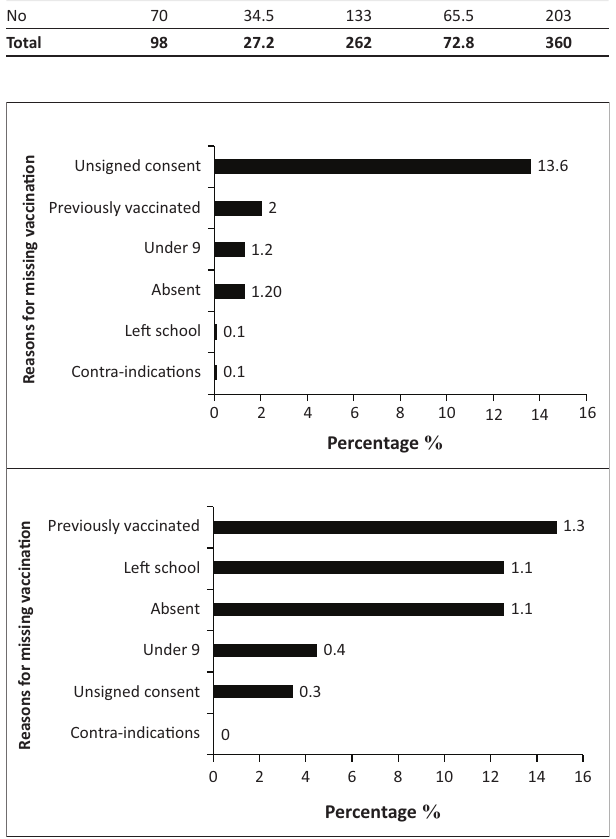
FIGURE 2: The proportion and reasons for missing vaccination during the March (a) and September (b) campaigns ( N = 22 057).